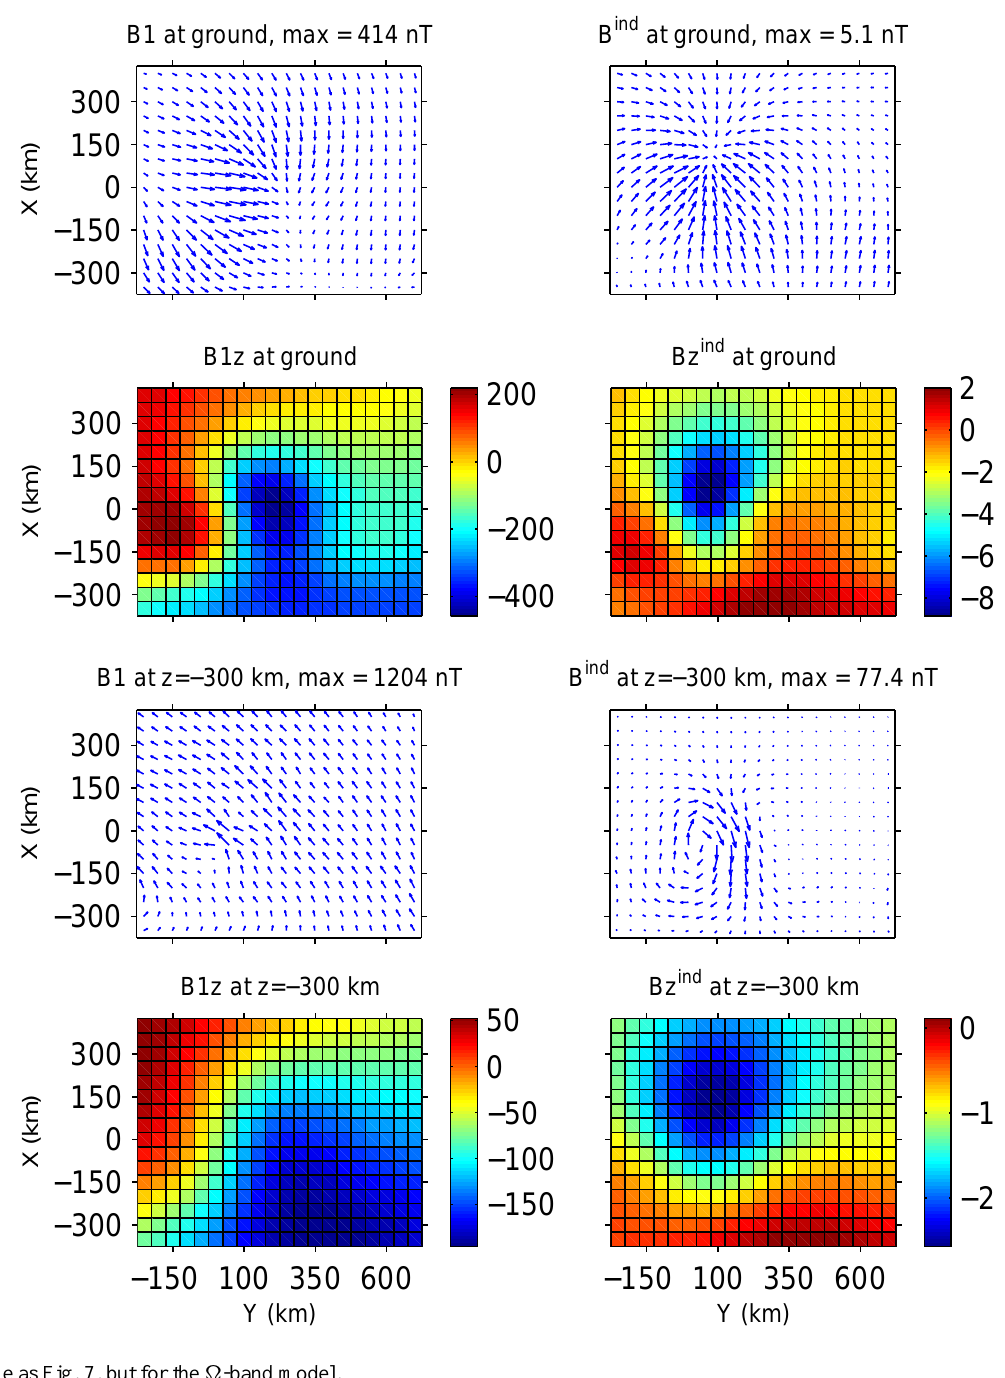
Fig. 16. Same as Fig. 7, but for the (cid:127) -band model.